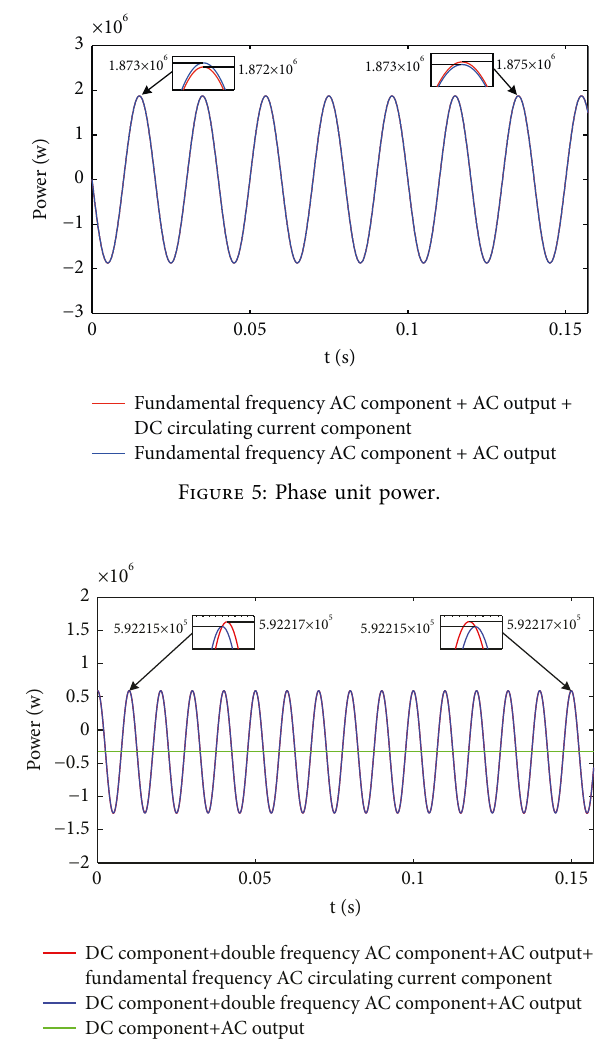
Figure 6: Power difference between upper and lower bridge